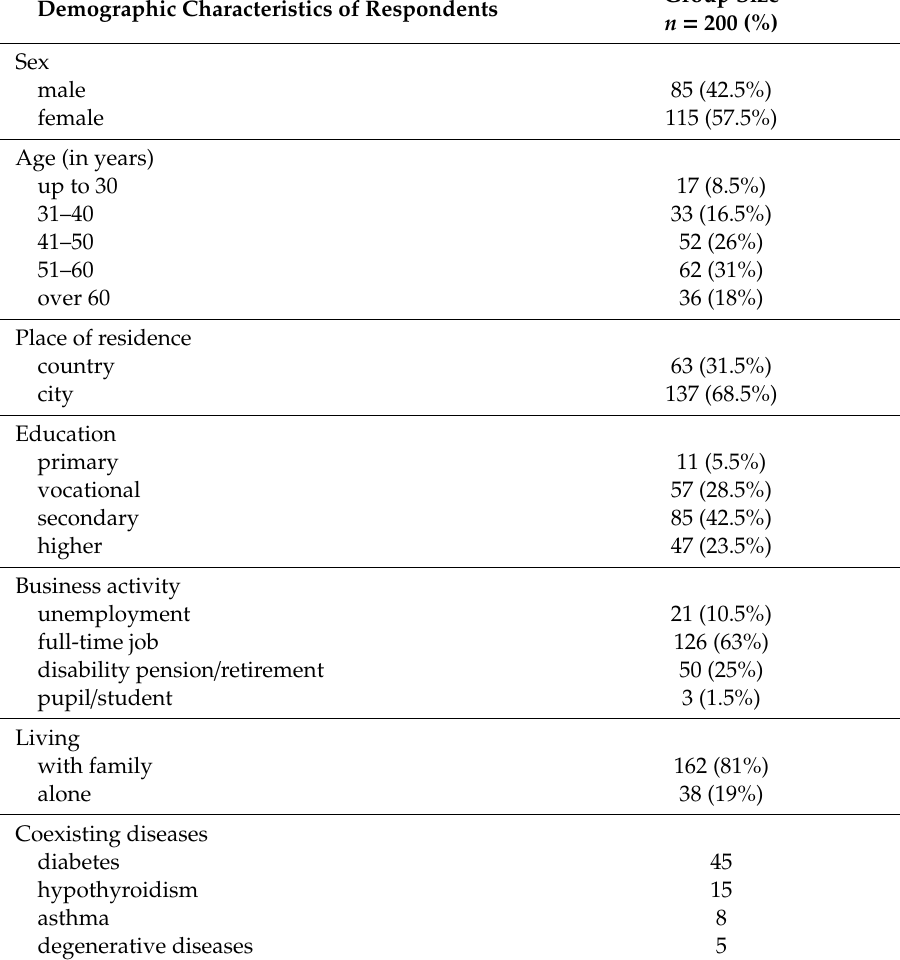
Table 1. The general characteristics of the study